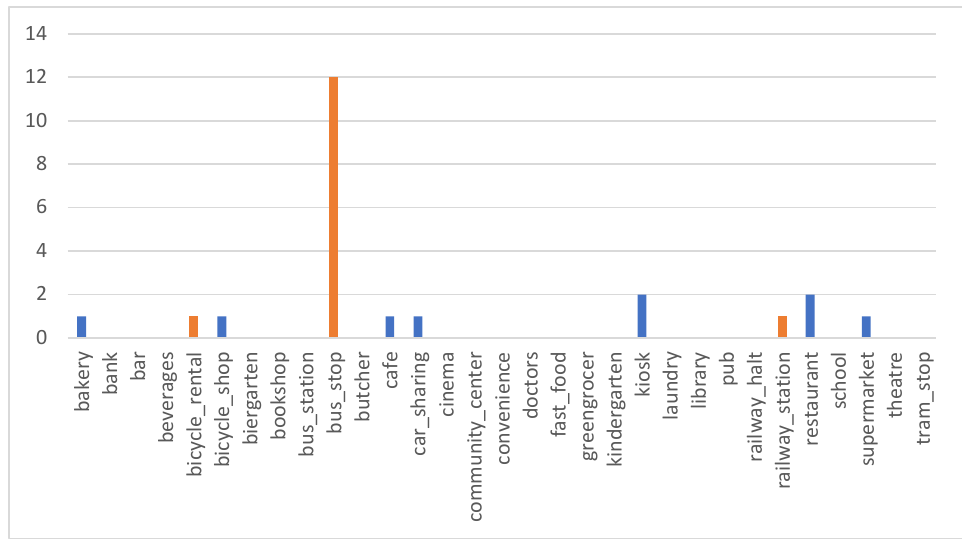
Figure 15. Number of POIs in the vicinity of 500 m in the surrounding of the office location Dieselstraße in Unterföhring, Munich.